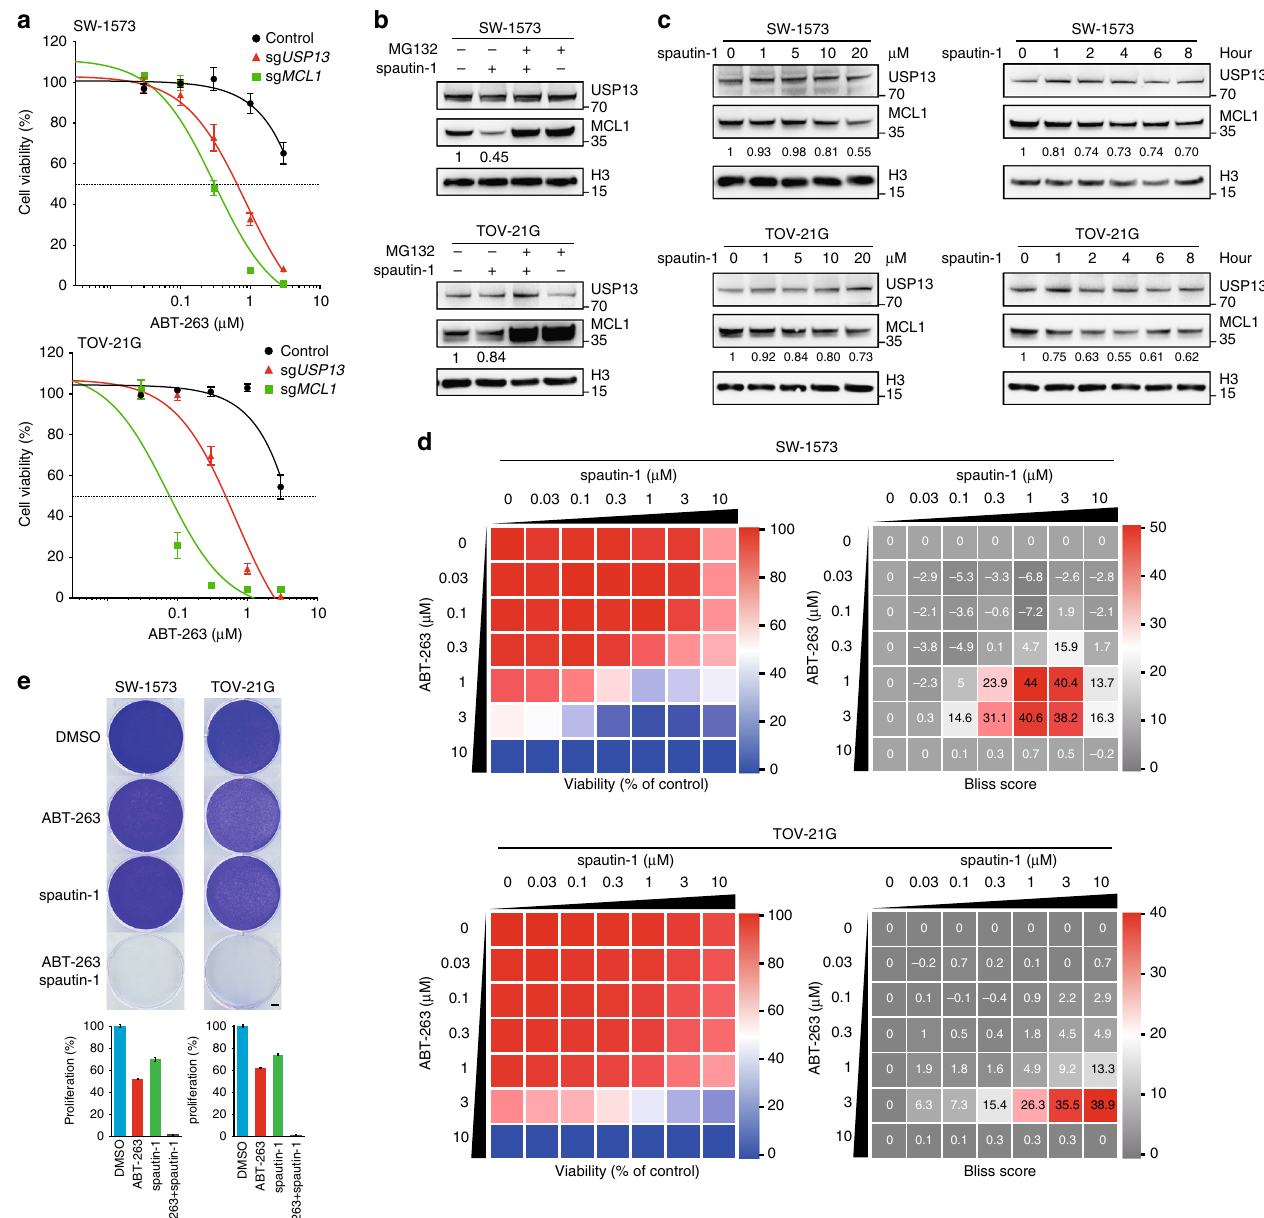
Fig. 6 Targeting USP13 sensitizes tumor cells to BH3 mimetics. a USP13 or MCL1 was knocked out in SW-1573 and TOV-21G cells using CRISPR/Cas9, and cell viability in the presence of ABT-263 was analyzed by Cell Counting Kit-8. Error bars indicated standard deviation (each condition contained three biological replicates). b SW-1573 and TOV-21G cells were treated with spautin-1 (10 μ M) and MG132 (10 μ M) for 6 h. Cell lysates were analyzed by western blotting using antibodies against USP13, MCL1 or H3. c Cells were treated with spautin-1 at indicated concentrations or for different time frames, and cell lysates were analyzed by western blotting using antibodies against USP13, MCL1 or H3. d Examples of synergistic activities of spautin-1 and ABT- 263 in SW-1573 and TOV-21G cells. Left: heatmaps of growth inhibition; right: heatmaps of Bliss synergy scores. e Cells were treated with DMSO, spautin-1 (1 μ M) and/or ABT-263 (1 μ M). The remaining cells were stained with crystal violet and quanti fi ed (scale bar = 3.5 mm). Error bars indicated standard deviation (each condition contained three biological